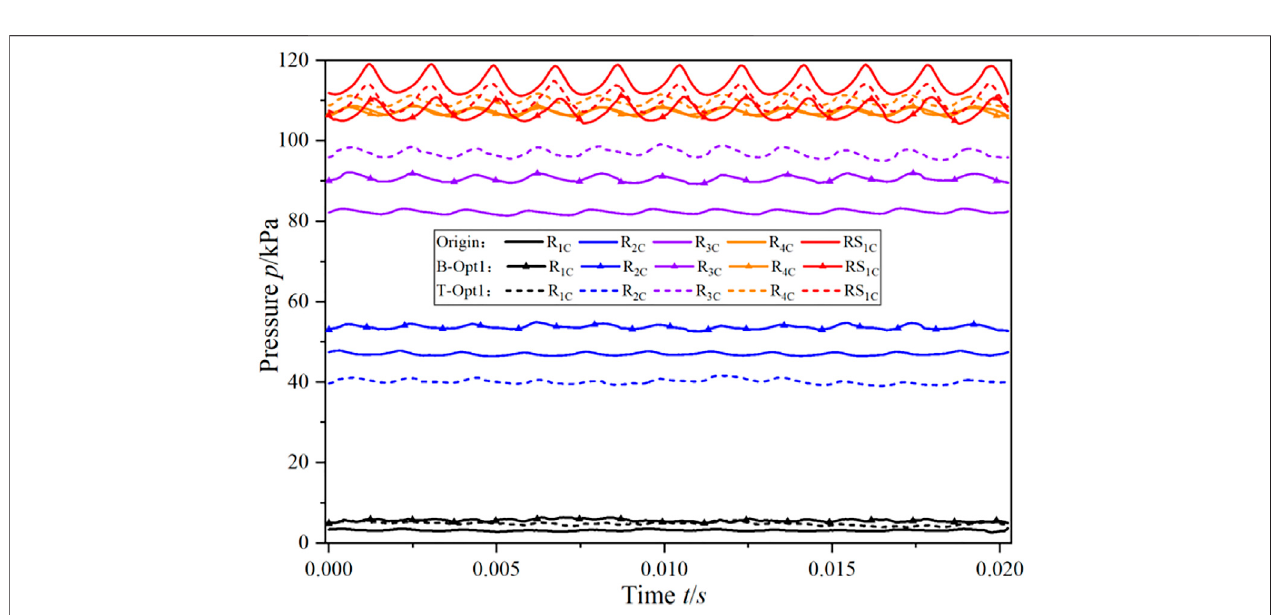
FIGURE 16 | Pressure variation of points R1C ~ R4C and RS1C (IGVF = 10%).